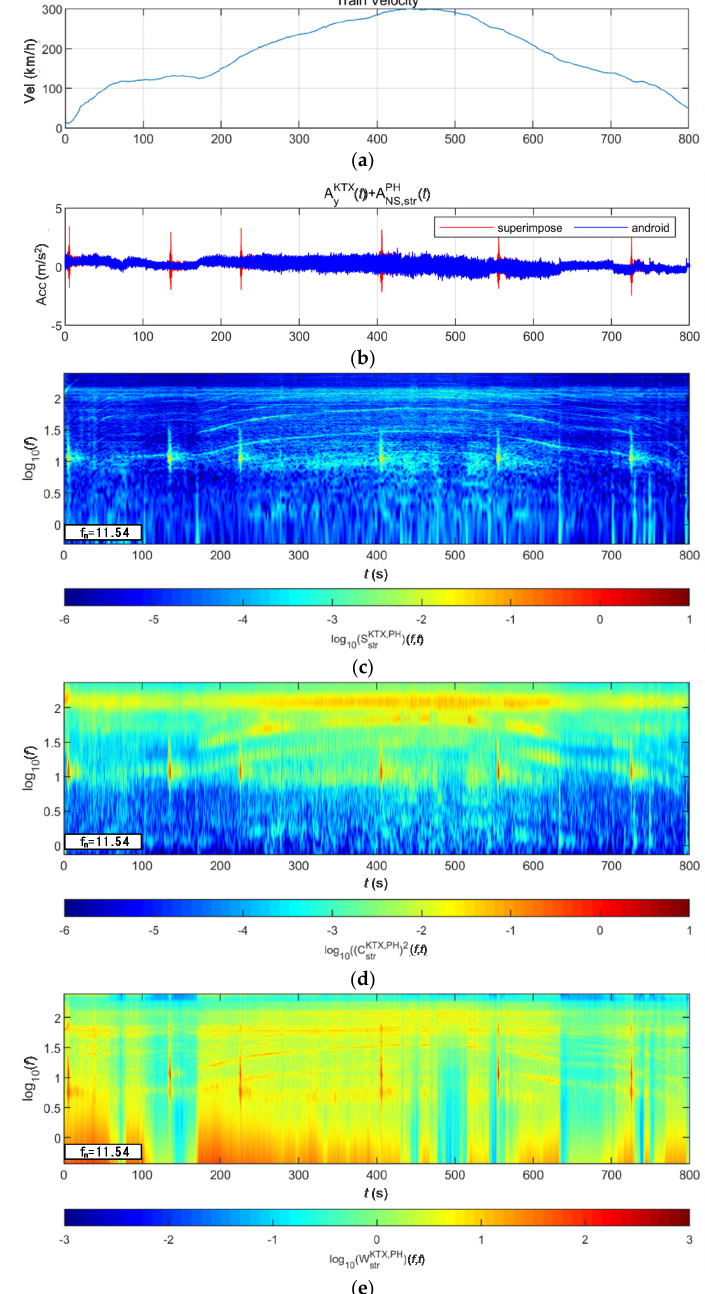
Figure 30. Combination of train data with BR2 bridge-response data from the Pohang earthquake (scaled to 1000-year return period): ( a ) velocity; ( b ) lateral acceleration time series; ( c ) STFT; ( d ) WT; ( e ) WVD.